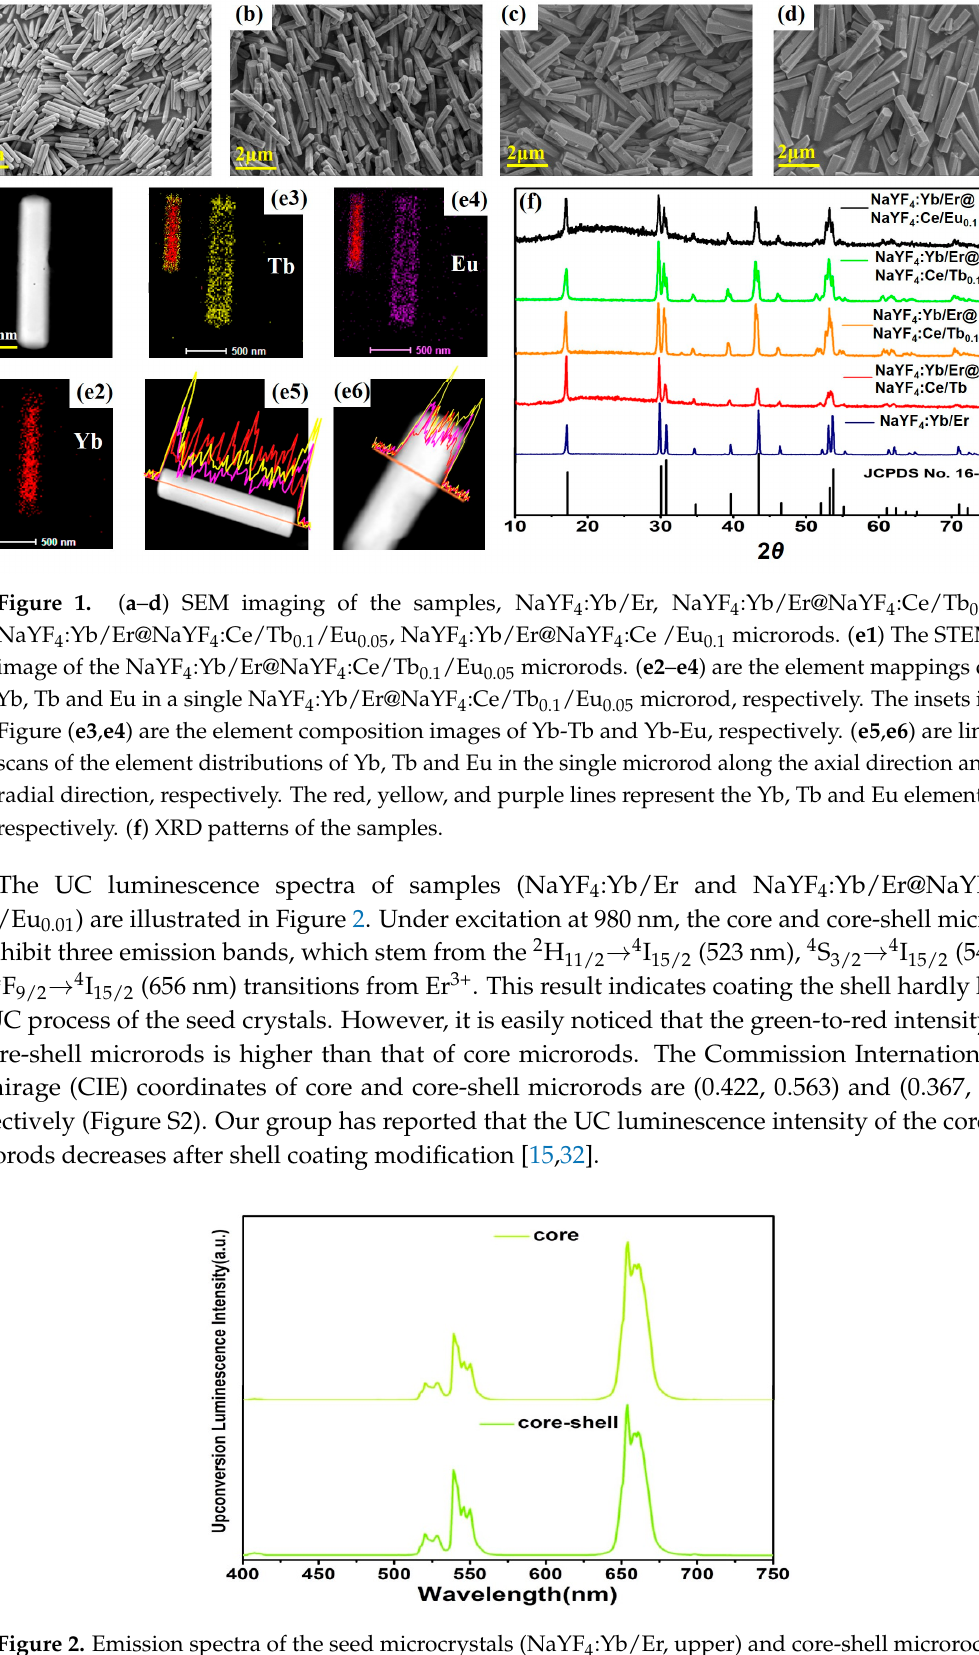
Figure 2. Emission spectra of the seed microcrystals (NaYF 4 :Yb/Er, upper) and core-shell microrods (NaYF 4 :Yb/Er@NaYF 4 :Ce/Tb 0.1 /Eu 0.1 , lower) under 980 nm excitation.